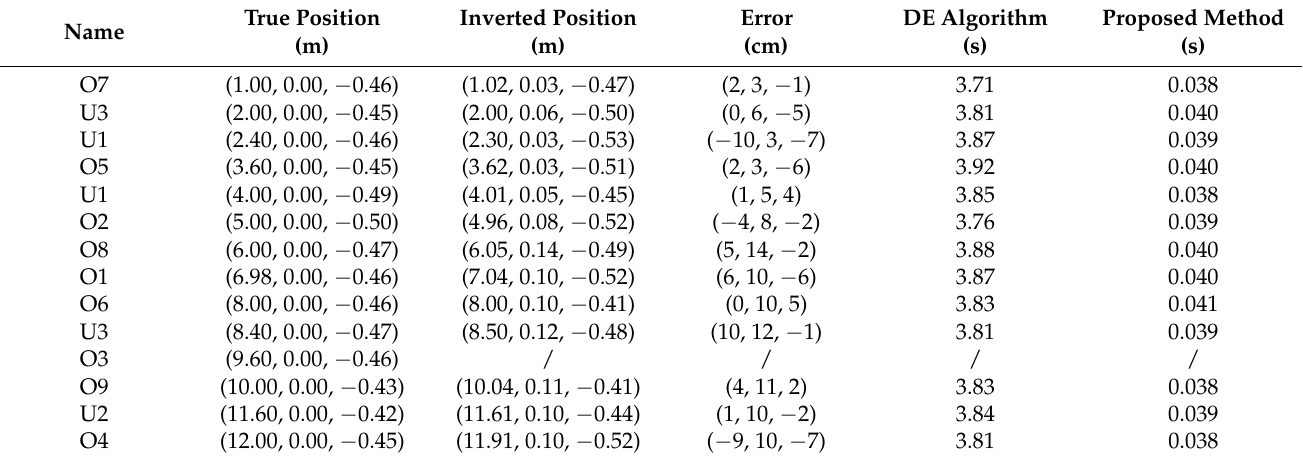
Table 6. Localization results of